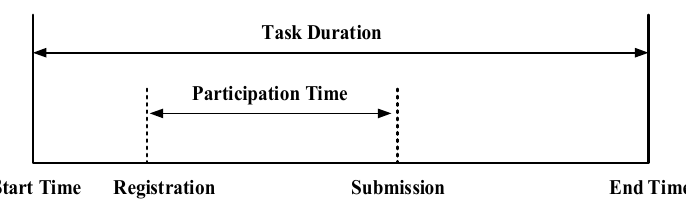
Figure 2. The stages of the crowdsourcing contest process.